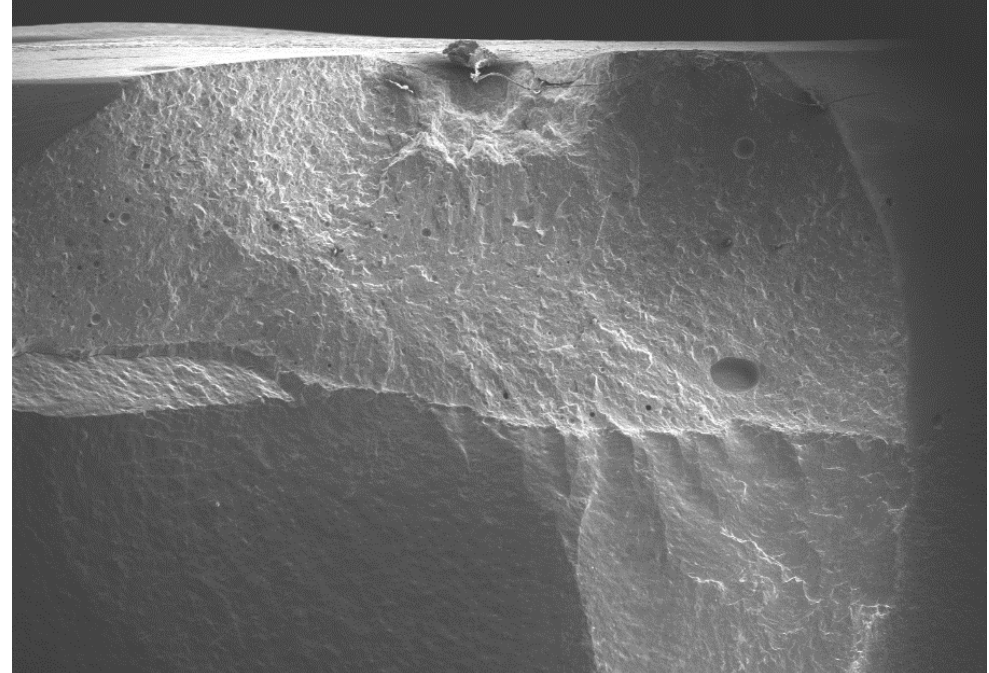
Figure 5. SEM micrograph of the fractured veneered-zirconia crown repaired with Tetric EvoCeram at magnification of 22×. Dent. J. 2020 , 8 , x FOR PEER REVIEW